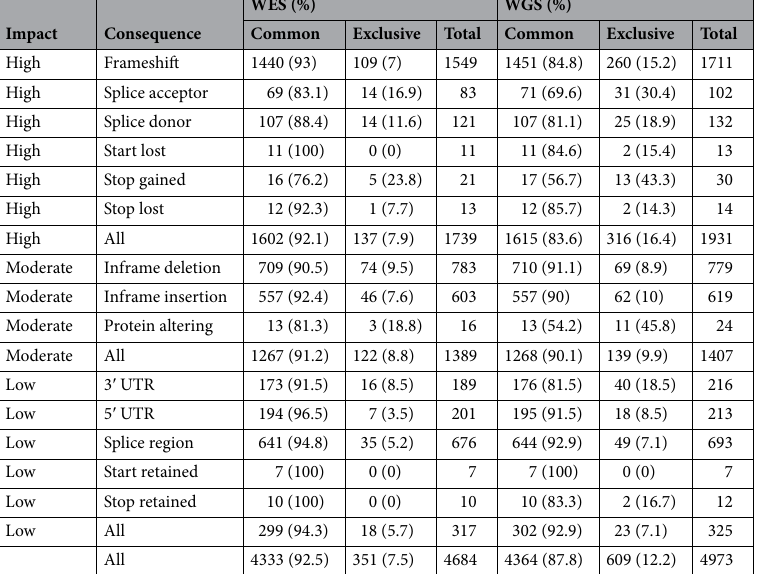
Table 3. Indel consequence counts of WES versus WGS as determined by variant effect